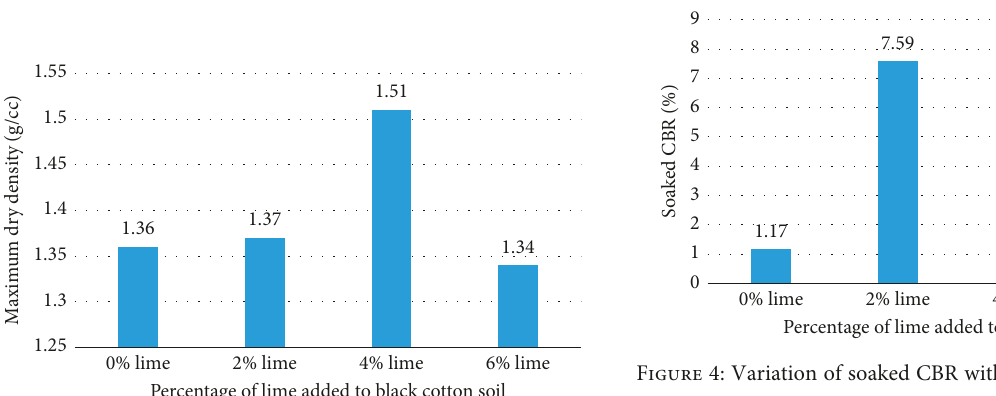
Figure 1: Variation of differential free swell index with varying percentages of lime.